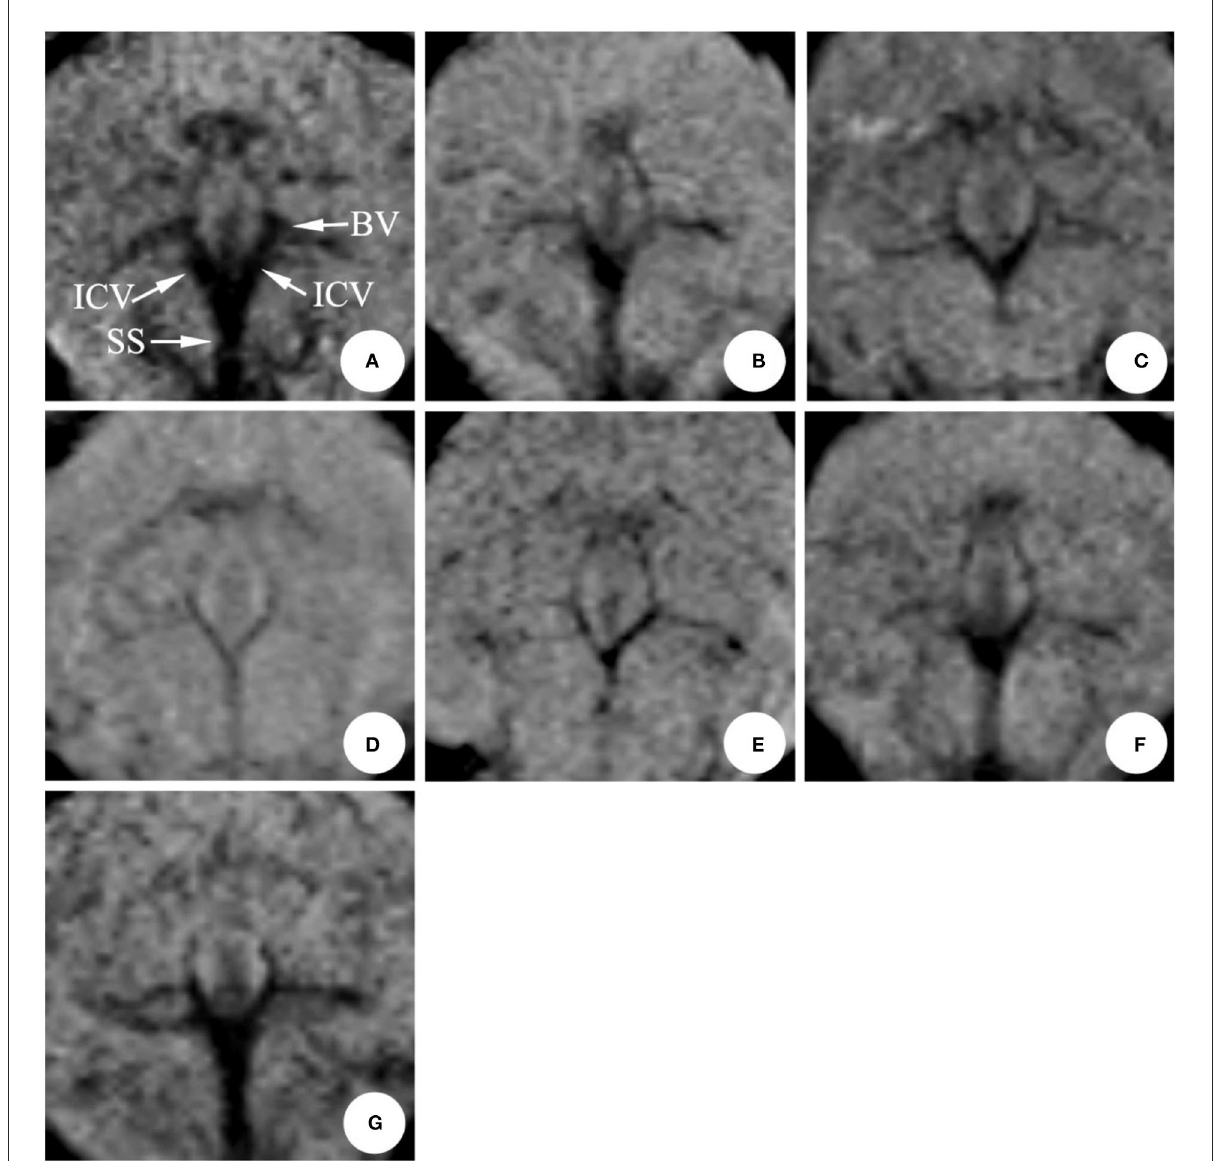
FIGURE4 The magnetic resonance performance of internal cerebral vein in the same rabbit SAH model within 0 ∼ 11 d (mIP). The diameter was obviously narrow after making the model in 1 d, eased after 3 d, and reached a peak around 5 ∼ 7 d, and gradually recovered during 9 ∼ 11 d. ICV, Internal cerebral vein; SS, Straight sinus; BV, Basilar vein. (A) 0 d; (B) 1 d; (C) 3 d; (D) 5 d; (E) 7 d; (F) 9 d; (G) 11